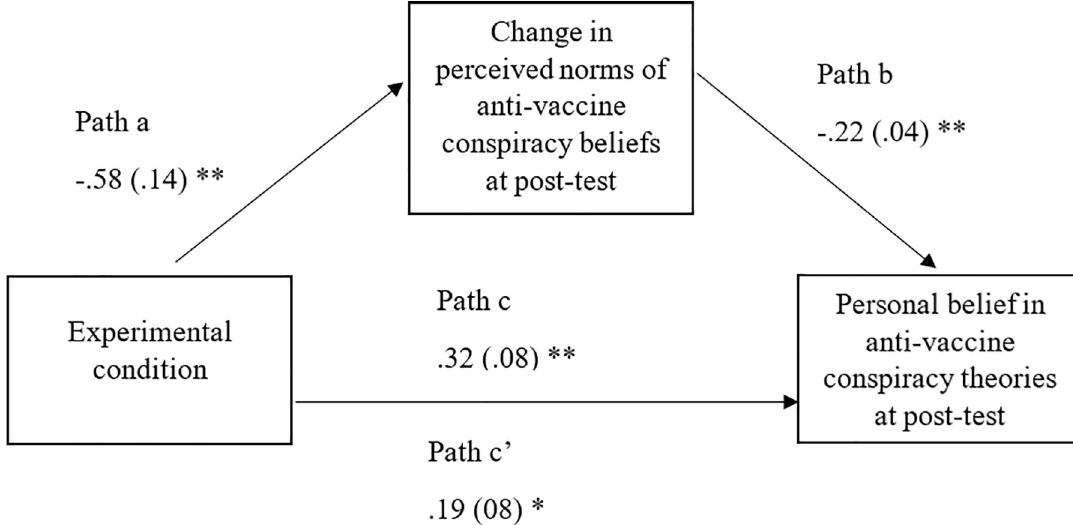
Fig 2. Model 4 showing mediation of the experimental condition reducing anti-vaccine conspiracy beliefs through reduced perceived norms of anti-vaccine conspiracy beliefs. � = p < .05, �� = p < .001.